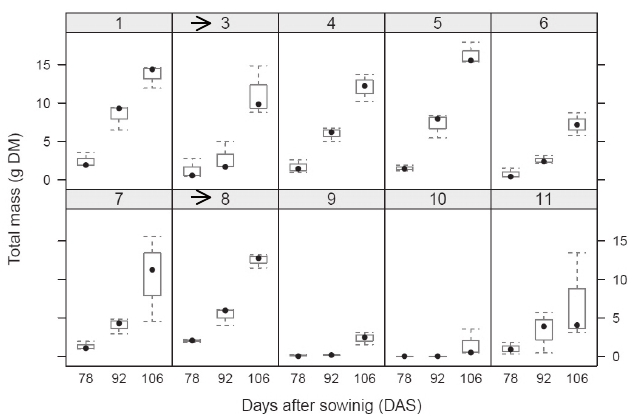
Fig. 2: Total biomass (shoot plus root) of four accessions of S. hermaph- rodita (1, 3, 4 and 5) and six biotypes of S. perfoliatum (6 to 11) observed at three harvests performed at 78, 92 and 106 days after sowing. Numbers of origins (panel labels) refer to those given in Tab. 1. The presence of significant differences between different ac- cessions at the final harvest is noted in Tab. 2. Arrows mark those accessions, which are the widely planted genetic material of the two